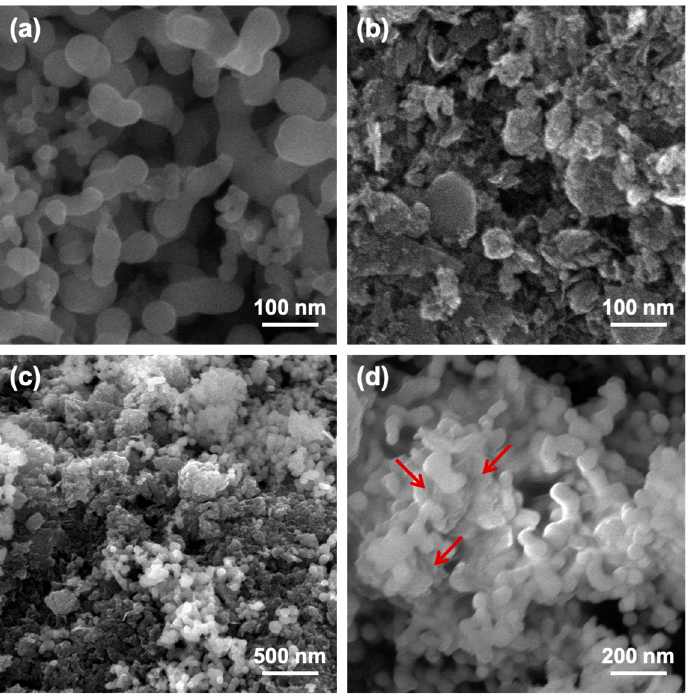
Figure 2. SEM images of ( a ) Si nanoparticle; ( b ) graphene; ( c , d ) Si-graphene (the red arrows highlight the graphene nanosheets).